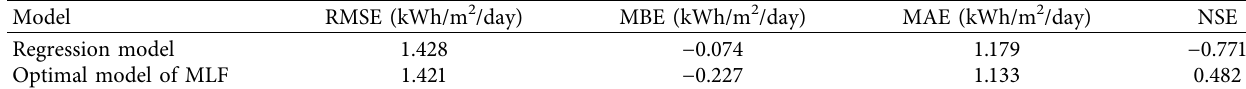
Table 6: Comparison of the regression and optimal models of MLF.